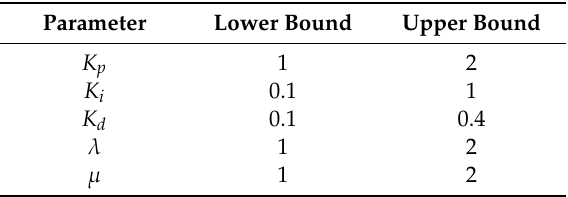
Table 6. Boundaries of the optimization